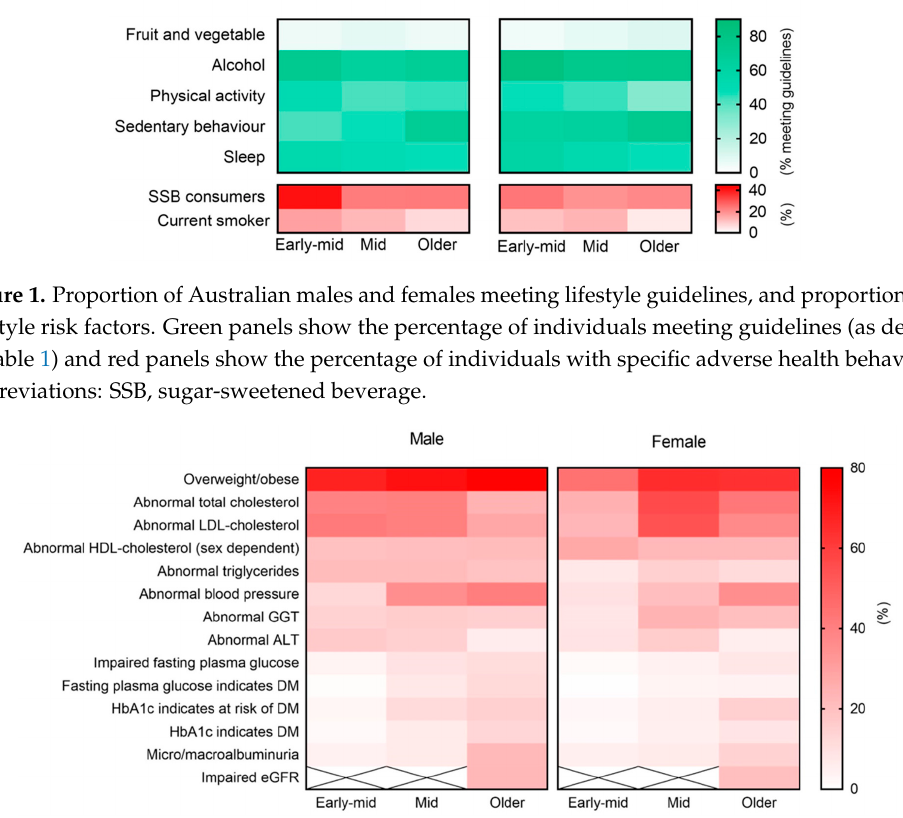
Figure 2. Proportion of Australian males and females with abnormal biomedical results throughout adulthood. Abbreviations: ALT, alanine aminotransferase; DM, diabetes mellitus; eGFR, estimated glomerular filtration rate; GGT, gamma-glutamyltransferase; HbA1c, glycated haemoglobin; HDL, high-density lipoprotein; LDL, low-density lipoprotein.